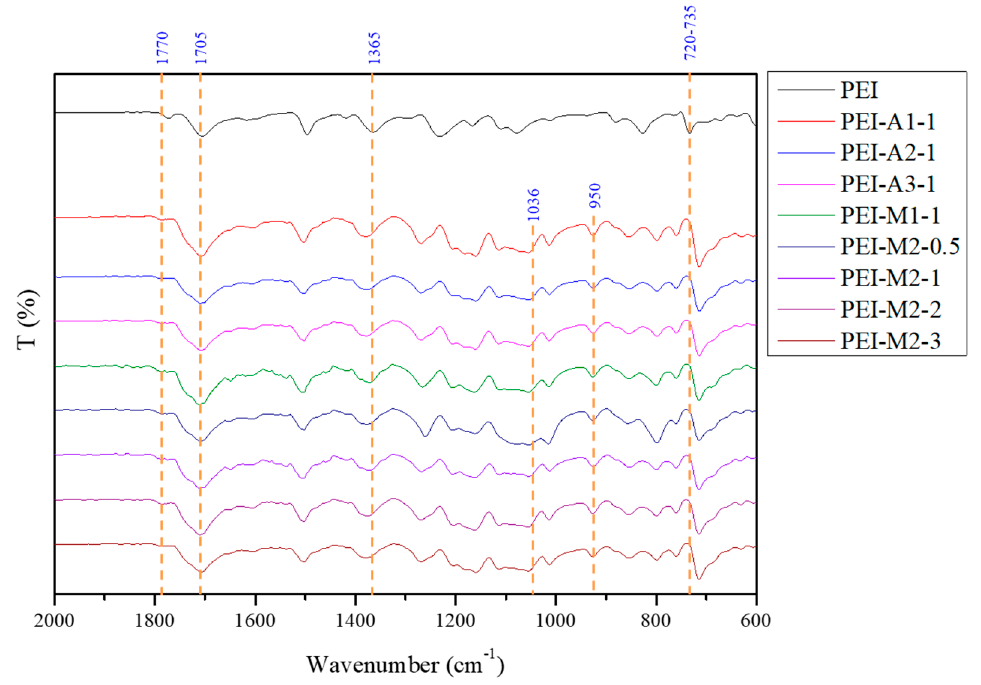
Figure 8. ATR-FTIR spectra of the polyester imide (PEI) and its corresponding composite membranes containing hydrophilic MSPs (A1, A2, and A3) and hydrophobic MSPs (M1 and M2).